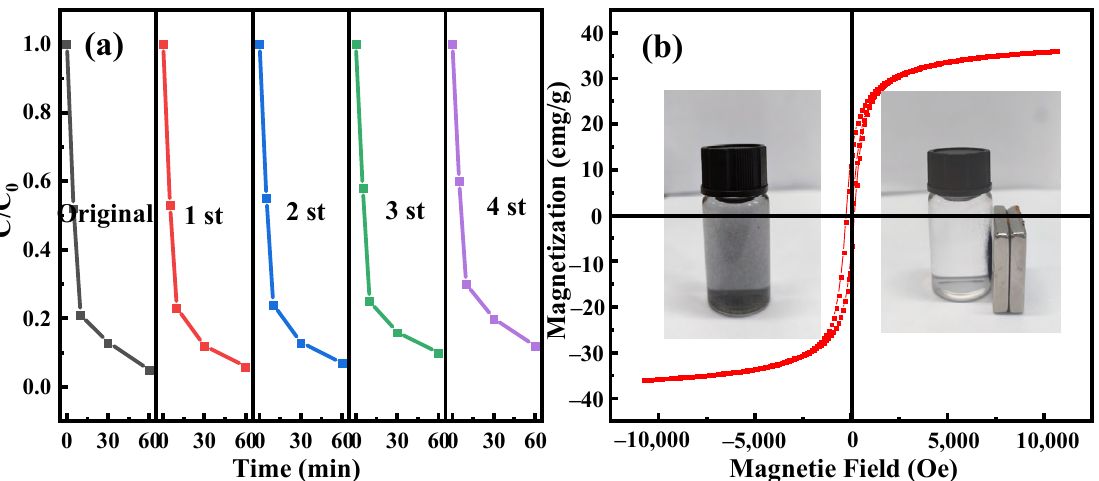
Figure 6. ( a ) Cycle experiments. ( b ) Optical photographs of magnetic separation process and magnetic properties of the CuFe 2 O 4 @BC catalyst. Reaction conditions: [CIP] = 10 mg/L, [catalysts] = 0.1 g/L, [PMS] = 2.5 mM, initial pH = 7.0, T = 25 °C.